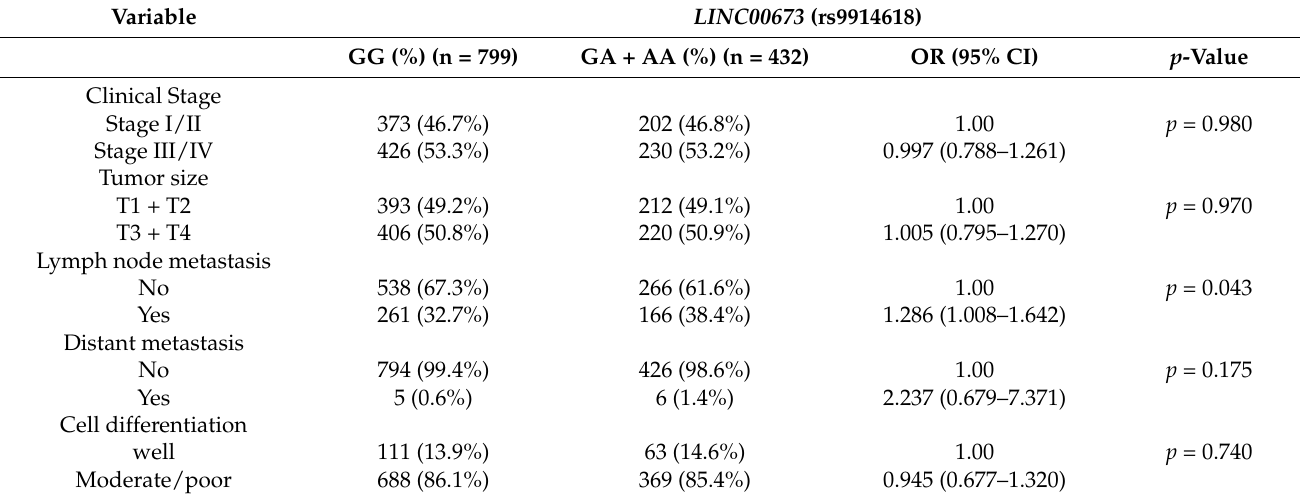
Table 3. Clinical statuses and LINC00673 rs9914618 genotype frequencies in oral cancer.